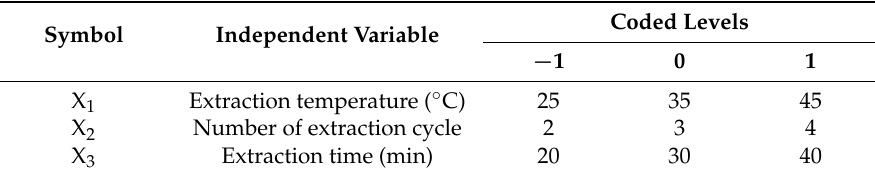
Table 5. Variables and experimental design levels for response surface analysis.